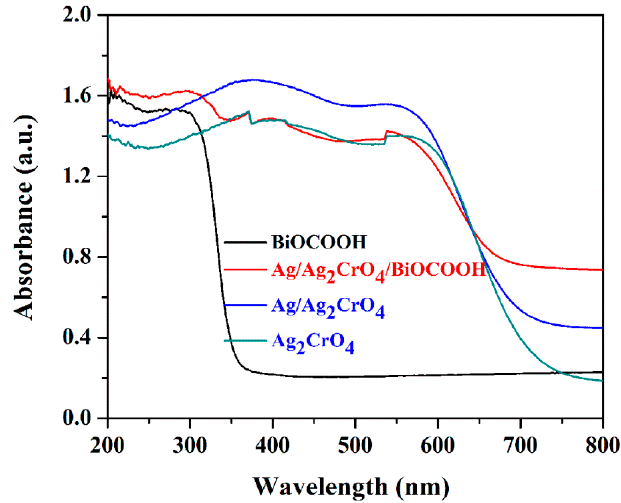
/ Ag / Ag / 2 CrO 4 , and Ag 2 CrO 4